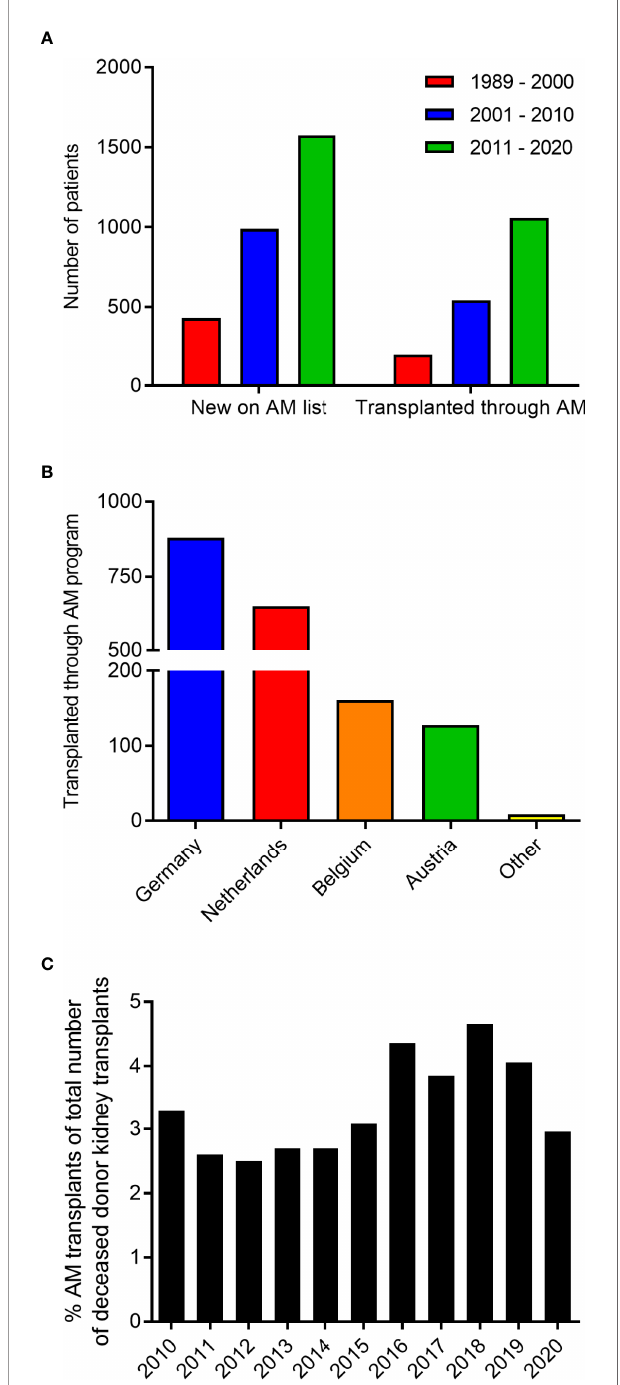
FIGURE 1 | Characteristics of patients enrolled in the AM program. (A) The number of patients included in the AM program and transplanted through the AM program from 1989 to 2020. (B) Country of origin of patients transplanted through the AM program. (C) Percentage of transplants through the AM program within all renal transplants from deceased donors within Eurotransplant in the last 10